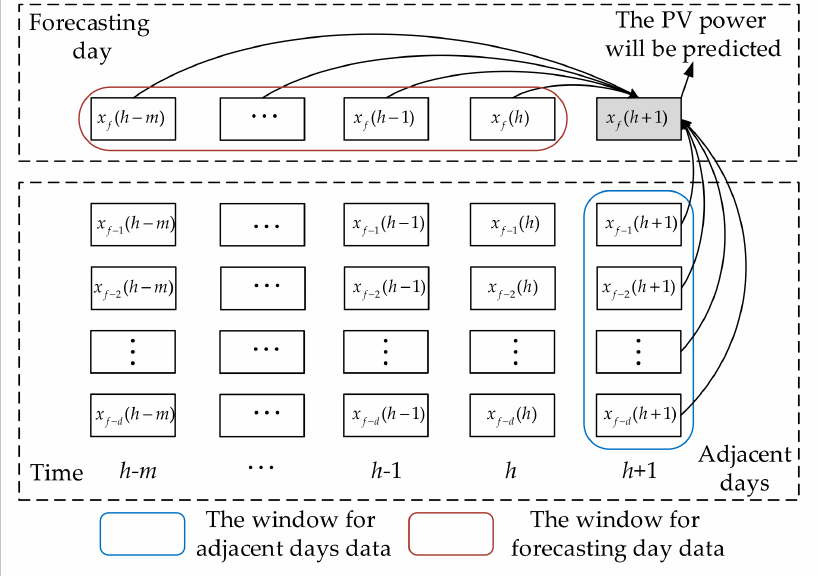
Figure 4. The inputs of RNN for the PV power